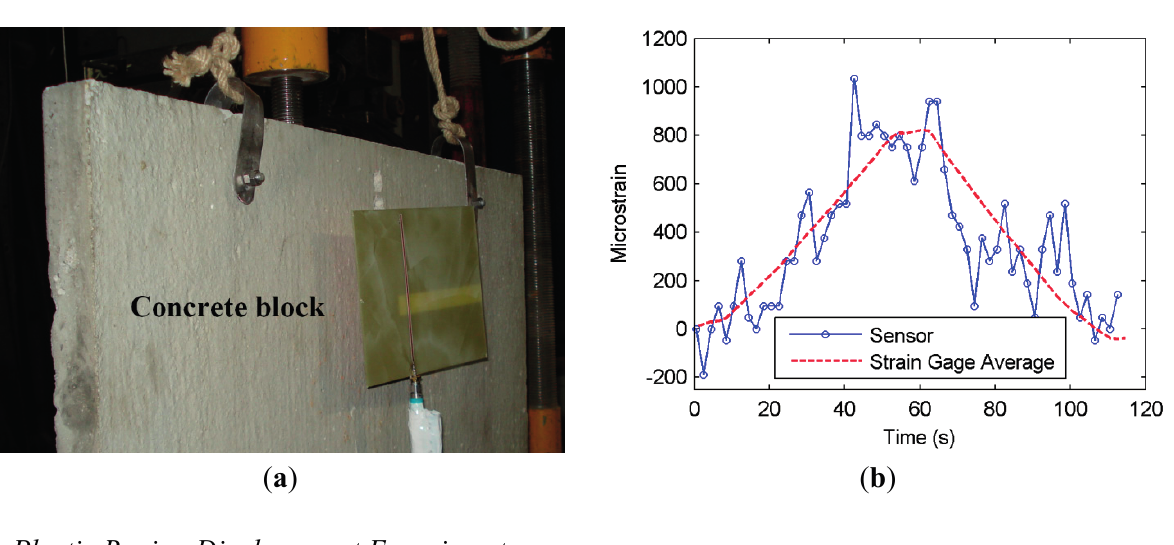
Figure 3. ( a ) Elastic (linear) region pulling and releasing experiments repeated with a concrete block of 4 cm thickness; ( b ) strain read by the metamaterial-based sensor and average strain gauge